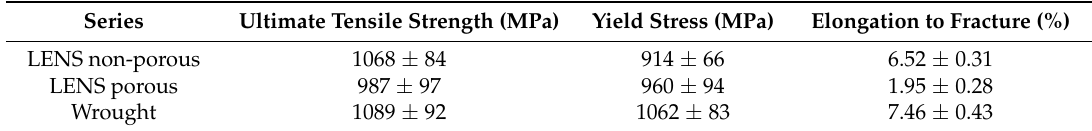
Table 2. Mechanical properties of all Ti-6Al-4V specimens.